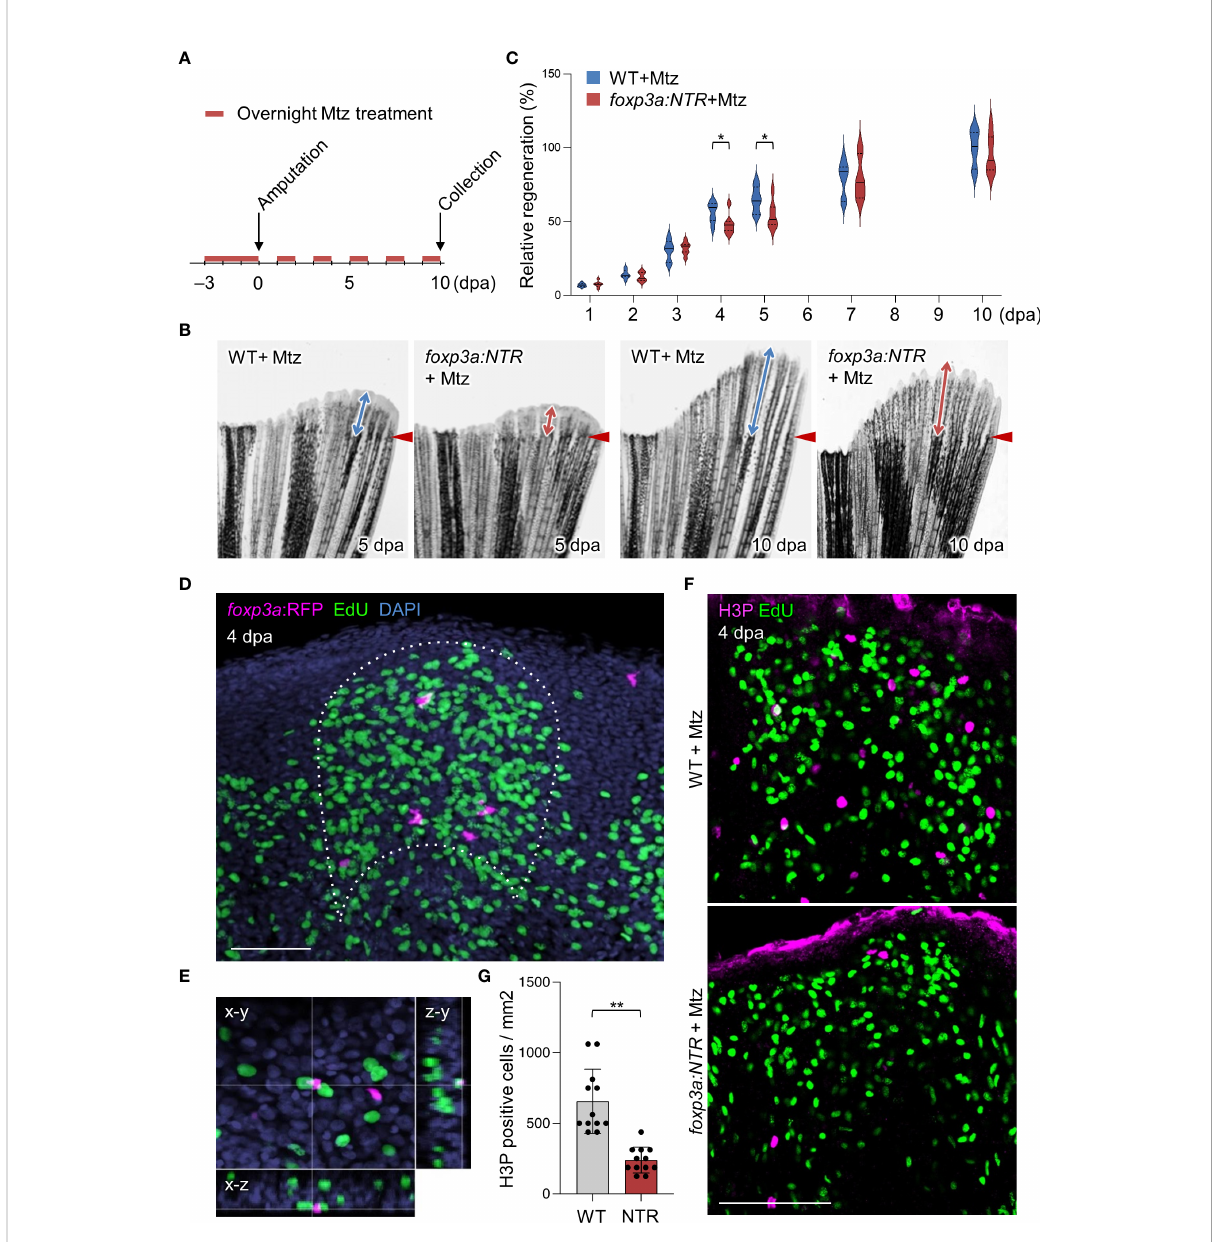
FIGURE 2 Tregs are required for blastemal proliferation during caudal fi n regeneration. (A) Experimental scheme for Mtz application in foxp3a:NTR fi sh to achieve Treg cell-speci fi c ablation and study caudal fi n regeneration. Three continuous days of overnight treatment of Mtz were performed before the initiation of caudal fi n amputation at day 0. (B) Bright fi eld microscopic images of caudal fi ns show the rate of fi n regeneration after 5 and 10 dpa in wild-type and Treg cell ablated fi sh. (C) Rate of fi n regeneration length was quanti fi ed in the wild-type fi sh against the Treg ablated fi sh. The average length of wild-type 10 dpa was considered as 100% length of fi n regeneration (mean ± SEM, n = 7, Student ’ s T-test). (D, E) Confocal images of fi n blastema at 4 dpa after EdU labeling indicates the foxp3a: RFP+ cells are spatially localized in close proximity of EdU+ blastemal cells (D) and sometimes they are also directly in contact with the EdU+ blastemal cells (E) . EdU was injected intraperitoneally 30 mins before the collection of fi n tissue. (F) The wholemount preparation of 4 dpa fi n with EdU and H3P immunostaining in wild-type and after Treg cell ablation. (G) Quanti fi cation of H3P+ cells in the 4 dpa fi n blastema of wild type and Treg ablated fi sh (mean ± SEM, n = 12, Mann – Whitney U test). *P < 0.01; **P < 0.001; Mtz, metronidazole; NTR, nitroreductase; Scale Bars, 50